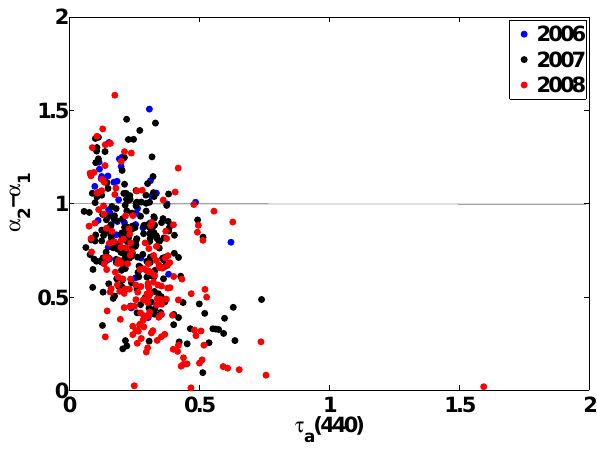
Fig. 6. Correlation between the coefficient α 2 − α 1 computed in the spectral interval 440–870nm and AOD (440nm), the IASBS site, October 2006 to September 2008.